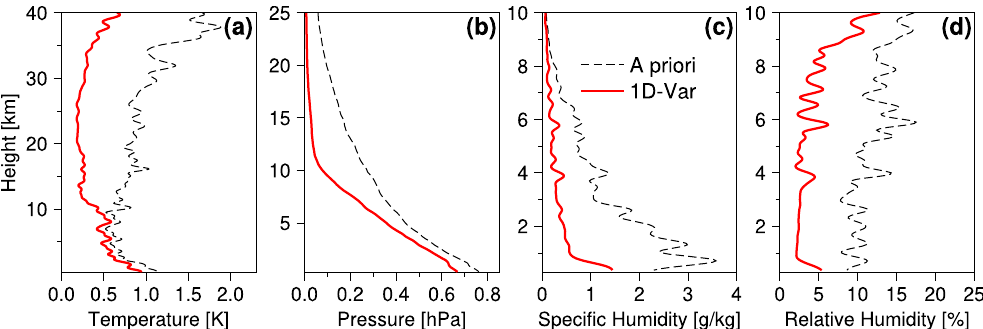
Figure 6. Errors of a priori profile (black dashed lines) and 1D-Var retrieval (red solid) for the sub-tropical case in Figure 5 in terms of: ( a ) temperature (°C), ( b ) pressure (hPa), ( c ) specific humidity (g kg −1 ), and ( d ) relative humidity (%). The error is defined as the standard deviation from the known truth.